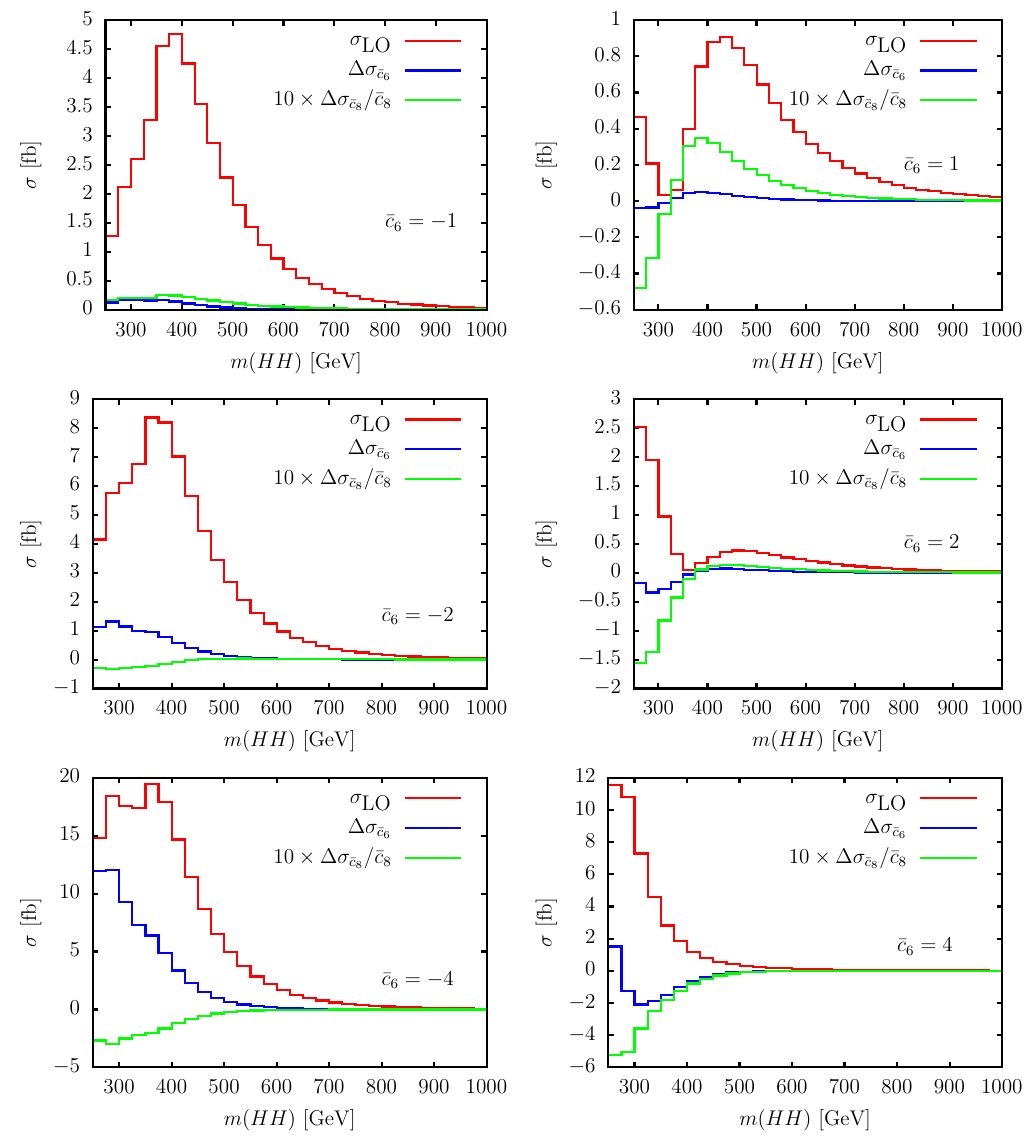
Figure 9 . Di(cid:11)erent contributions ( (cid:27) LO , (cid:1) (cid:27) (cid:22) c for di(cid:11)erent (cid:22) c 6